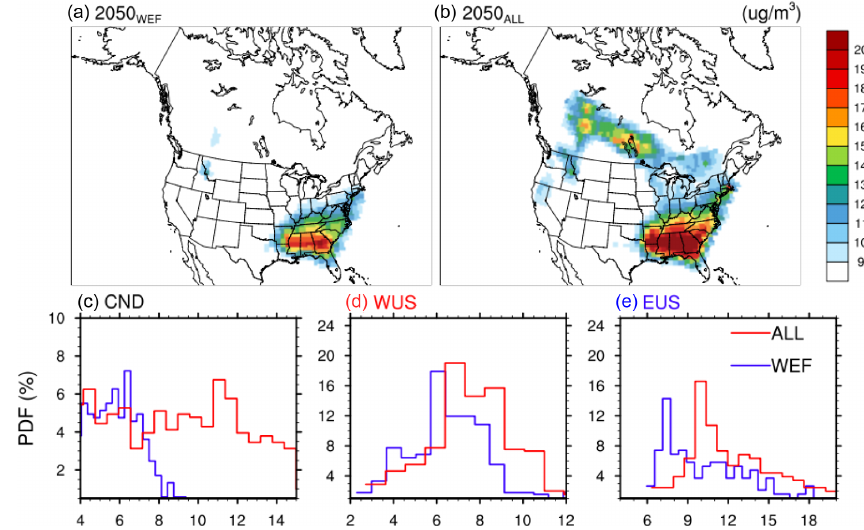
Figure 7. Spatial distribution and probability density function of PM 2 . 5 concentration in the 2050s. (a–b) Spatial distribution of decadal- average summer (JJA) mean PM 2 . 5 concentration over North America in the mid-21st century from 2050 WEF (wildfire-emission-free) (a) and 2050 ALL (wildfire-emission-inclusive) (b) . (c–e) Probability density functions (PDFs) of the same within the three regions shown in Fig. 2b for Canada (CND) (c) , the western US (WUS) (d) , and the eastern US (EUS) (e) , respectively, for the 2050 WEF (blue) and 2050 ALL (red) runs. The y axis indicates the probability of occurrence of different PM 2 . 5 values shown on the x axis. Only grids over land in North America are used to generate the PDFs. Note the different ranges of values shown on the y and x axis in (c) – (e) . The color bar and the x axis for panels (c) – (e) indicate PM 2 . 5